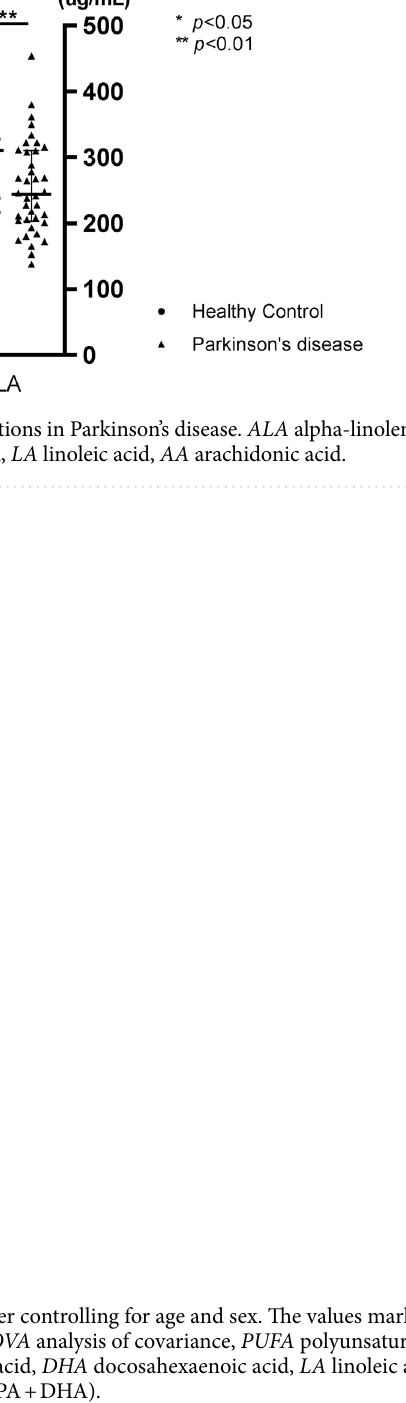
Table 1; Fig. 1). The ratio of n-6 to n-3 PUFA (n-6/n-3 ratio) from the five PUFA and the plasma levels of EPA and DHA were not different between patients with PD and controls. The effects of group on plasma levels of ALA, LA, and AA were maintained after controlling for age and sex by analysis of covariance [F(1,66) = 5.045, p = 0.028 for ALA, F(1,66) = 9.059, p = 0.004, and F(1,66) = 5.431, p = 0.023 for AA; Table 2]. When subgroup analysis was performed to evaluate the effect of anti-parkinsonian medications, only the plasma level of LA was lower in patients taking catechol- O -methyltransferase inhibitor compared to those who did not (211.8 ± 50.4 μg/ mL versus 269.2 ± 71.0 μg/mL, respectively, p = 0.025 [Supplementary Table S1]). There were no differences in dietary intake including total energy, total fat, cholesterol, total fatty acids, saturated fatty acids, monounsaturated fatty acids, and PUFA between patients with PD and controls (Table 3).